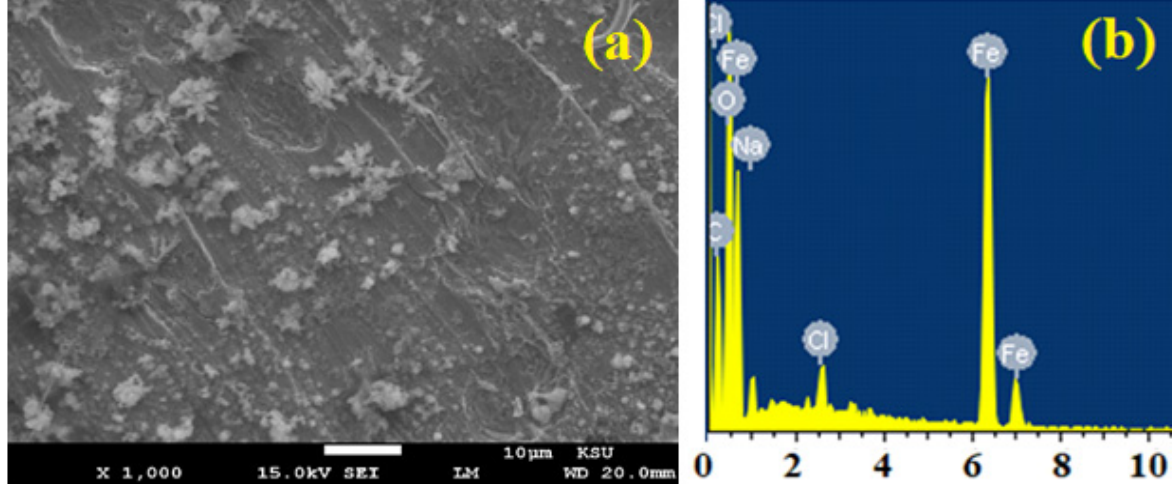
Figure 7. (a) SEM image and (b) EDX profile spectrum after 1 h holding the potential at − 475 mV (Ag/AgCl) for the surface of the iron rod that was immersed for 48 h in 3.5% NaCl + 5 × 10 − 4 M MAO solution.